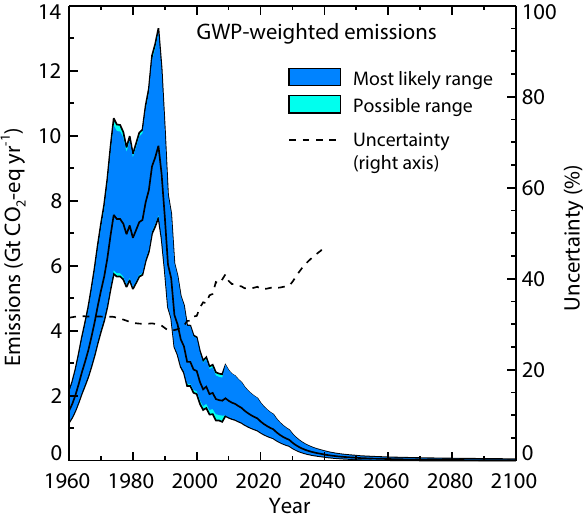
Fig. 9. ODP-weighted anthropogenic emissions from 1960 to 2100 using the lifetimes from SPARC (2013) and with uncertainties ap- plied to all parameters. Shown are the median values and 95% con- fidence interval based on the possible (orange) and most likely (red) uncertainty ranges in lifetimes. The relative uncertainties (95% confidence interval) are also shown as percentages of the median for the possible (dashed line) and most likely (dotted line) ranges until 2040, when the emissions become very small. The contribu- tion from natural emissions of CH 3 Br and CH 3 Cl (not shown in the figure) is in total about 0.12Mt CFC-11eq.yr − 1 .